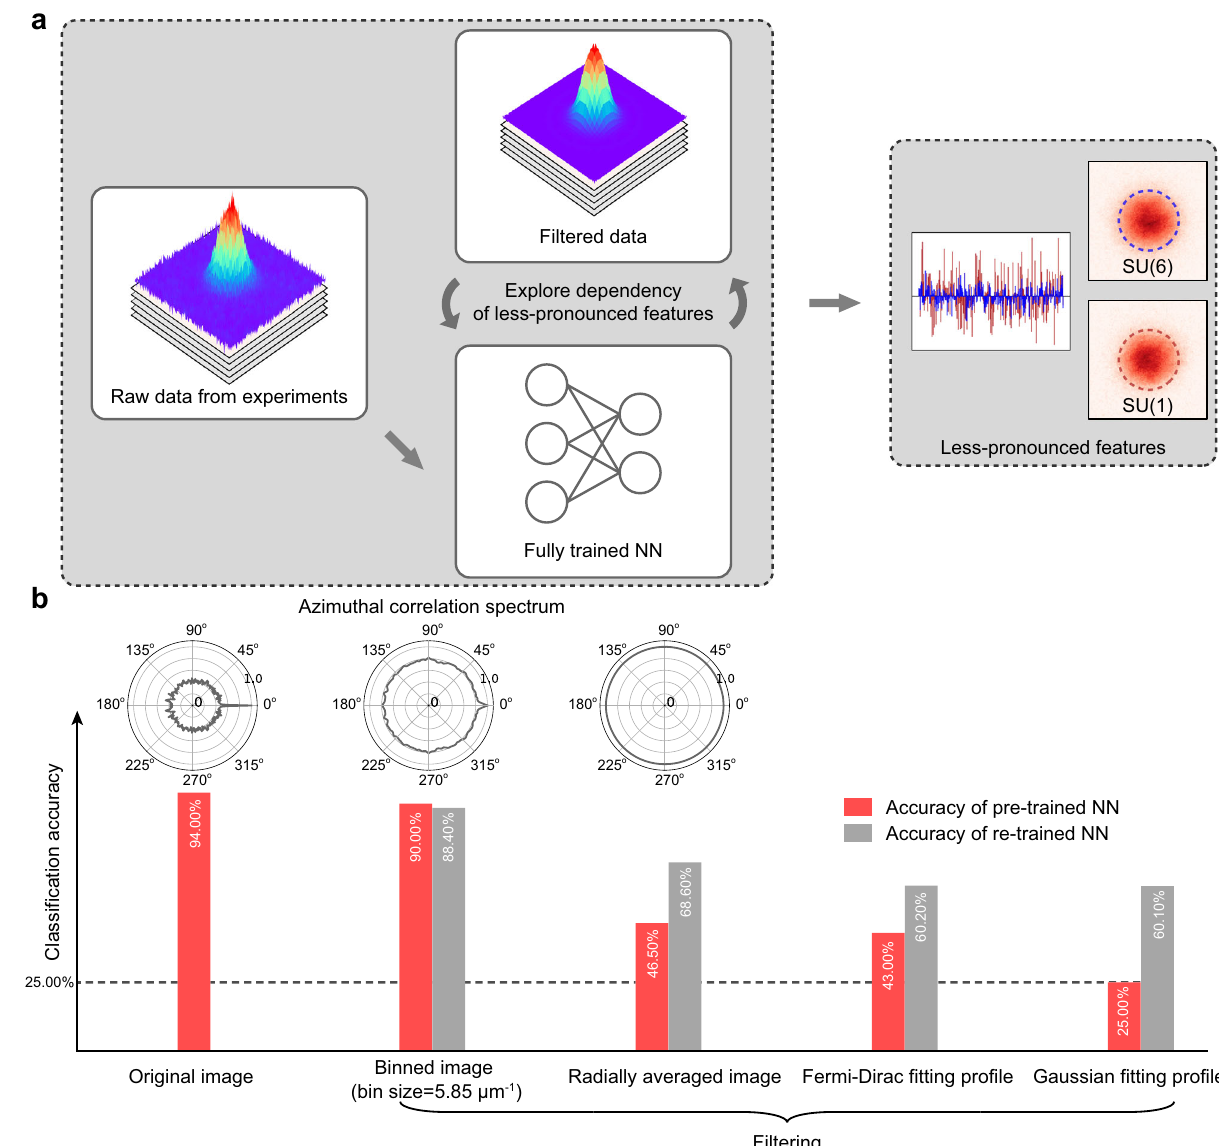
Fig. 2 Exploring less-pronounced effects with NNs using deliberately fi ltered experimental images. a Our heuristic machinery to uncover less- pronounced effects. b Effect of image fi ltering on the classi fi cation accuracy by neural networks trained with original (red) and fi ltered (gray) experimental images. The retraining process follows the same procedure of original training with fi xed neural network parameters and hyper-parameters (e.g., the number of epochs and learning rate). In the inset, the azimuthal correlation spectrums calculated at k = 58.5 μ m − 1 are